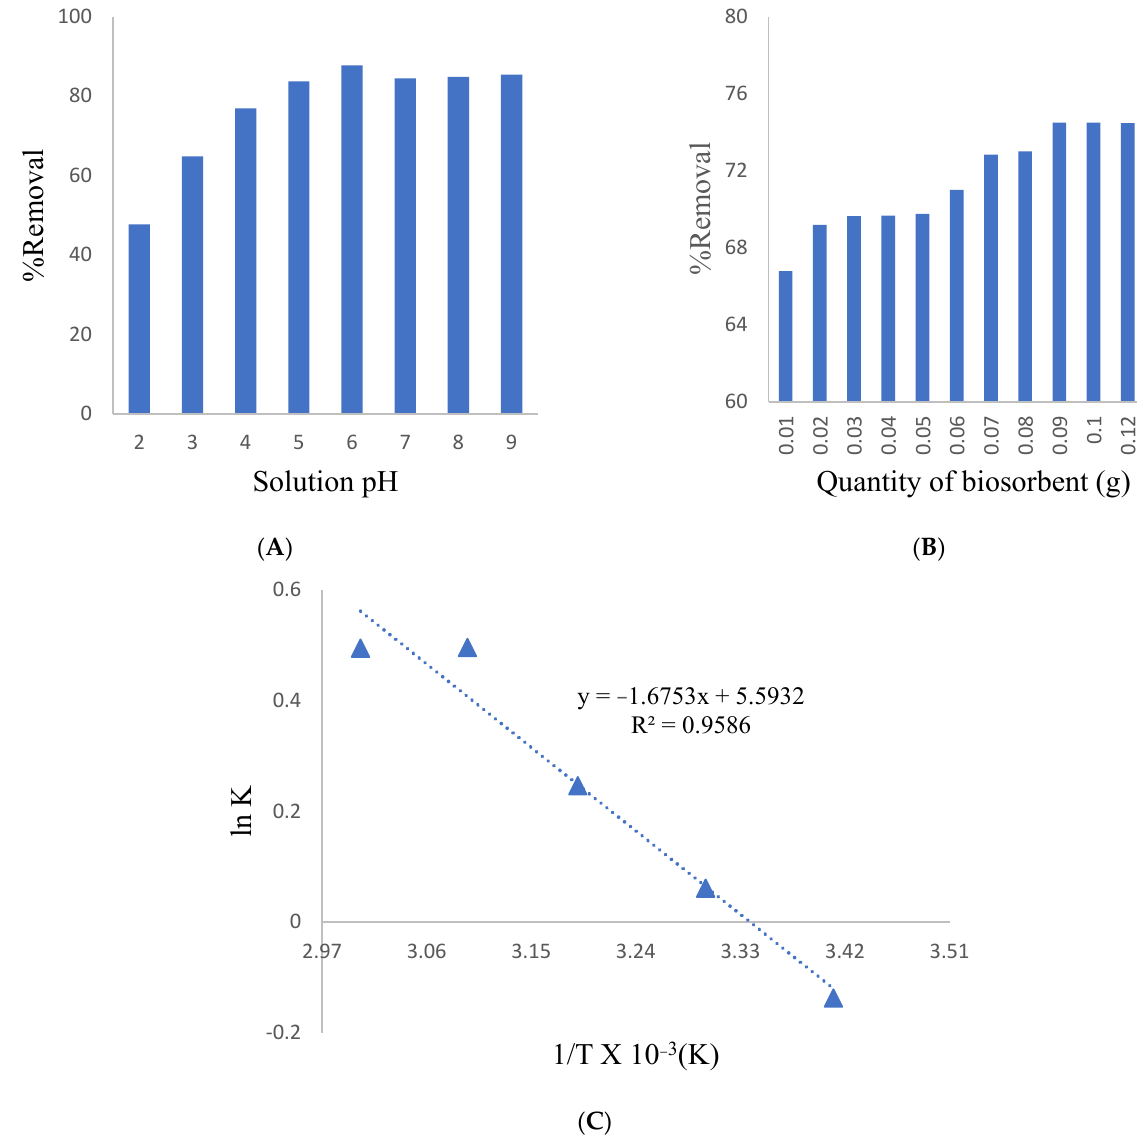
Figure 4. ( A ) Effect of pH ( B ) Effect of mass of biosorbent ( C ) Van ′ t Hoff plot.